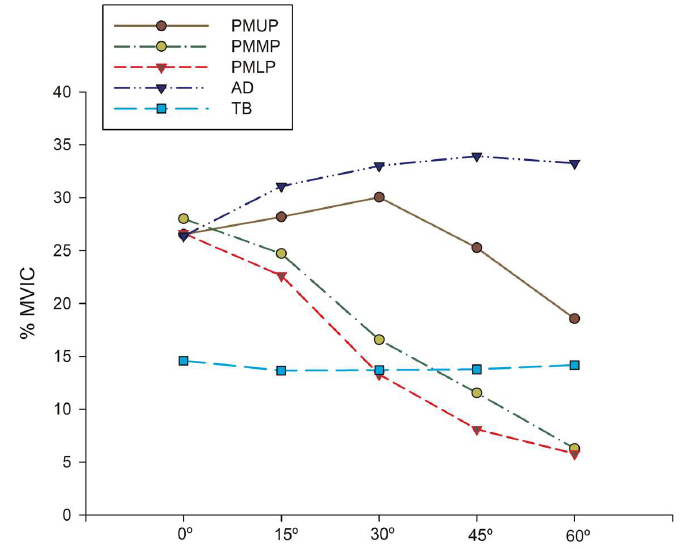
Figure 3. EMG activity (% maximal voluntary isometric contraction (MVIC)) of each muscle in relation to different bench press inclinations. Table 2. Pairwise comparisons between the EMG activity (relative to % MVIC) of each muscle and the bench press inclination.